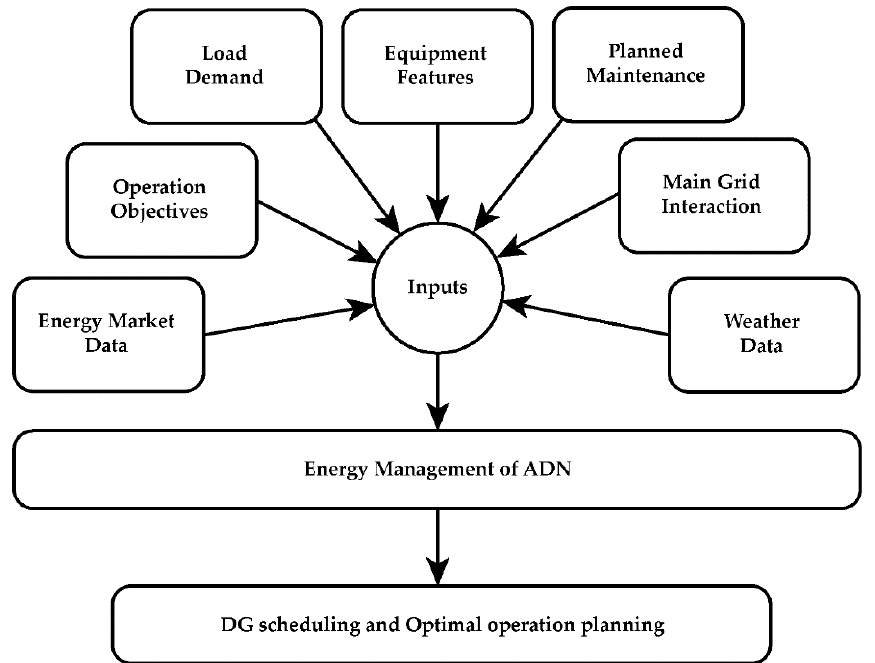
Figure 10. Energy management system of the future distribution grids, inspired by Gu et